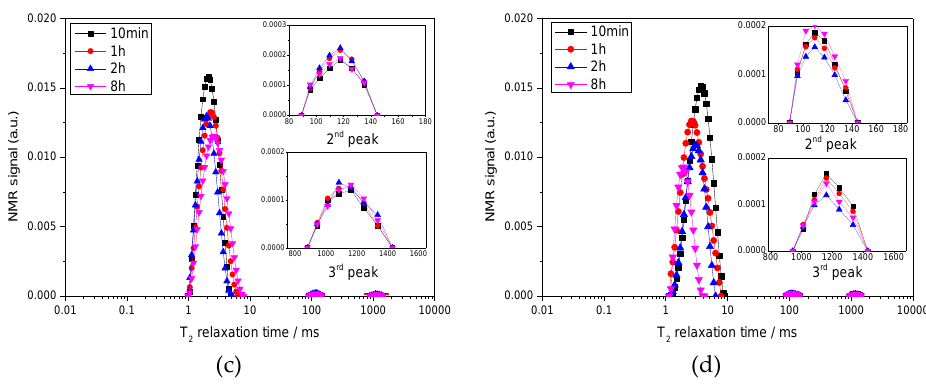
Figure 6. The short-duration T 2 relaxation time of the CPB mixture with different hydration times when polynaphtalene sulfonate dosage is: ( a ) 0%, ( b ) 0.2%, ( c ) 0.4%, and ( d ) 0.8%.